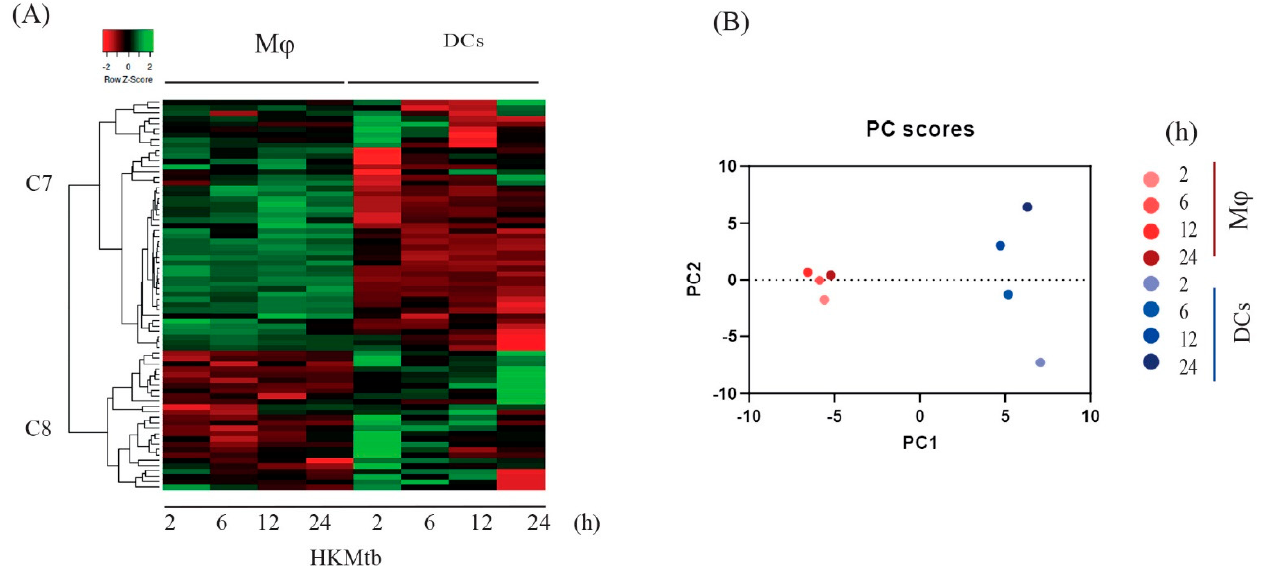
Figure 3. Phagocytosis of HKMtb induced distinct PDZ gene expression patterns in human monocyte-derived DCs and M ɸ . ( A ) Heatmap showing hierarchical clustering of the PDZ gene expression profile changes of both APCs stimulated at 2, 6, 12, and 24 h with HKMtb s referenced to unstimulated M ɸ and DCs. Data are presented as Z–score, corresponding to the change of expression of each time point respect to the mean of changes during the entire time course, where negative Z–score indicates a decrease (red), and positive Z–score indicates an increase (green) of each PDZ gene. ( B ) PCA analysis of qPCR data from M ɸ and DCs stimulated with HKMtb for 2, 6, 12, and 24 h.